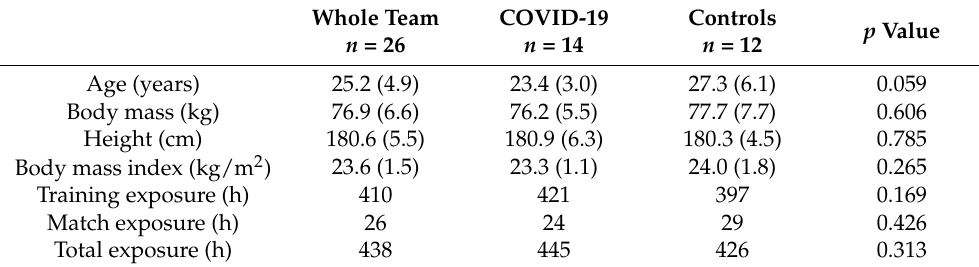
Table 1. General characteristics of the football players at the beginning of the 2020–2021 season. Whole Team COVID-19 Controls p Value n = 26 n = 14 n = 12 Age (years) 25.2 (4.9) 23.4 (3.0) 27.3 (6.1) 0.059 Body mass (kg) 76.9 (6.6) 76.2 (5.5) 77.7 (7.7) 0.606 Height (cm) Body mass index (kg/m 2 ) 0.265 Training exposure (h) 410 421 397 0.169 Match exposure (h) 26 24 29 0.426 Total exposure (h) 438 445 426